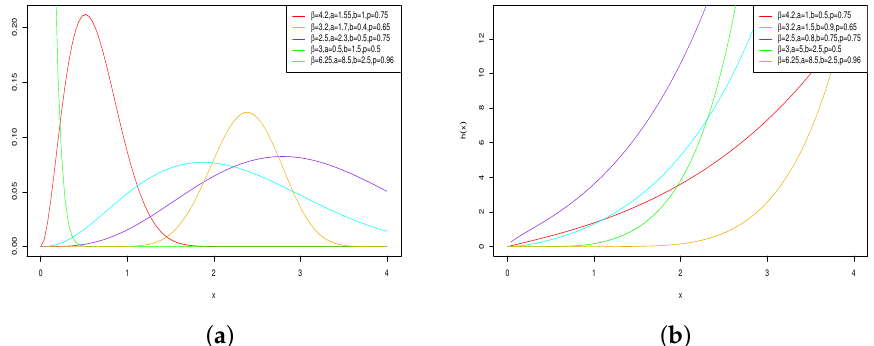
Figure 2. Examples of plots of the ( a ) pdf and ( b ) hrf of the OELGa distribution for various values of p , β , a and b